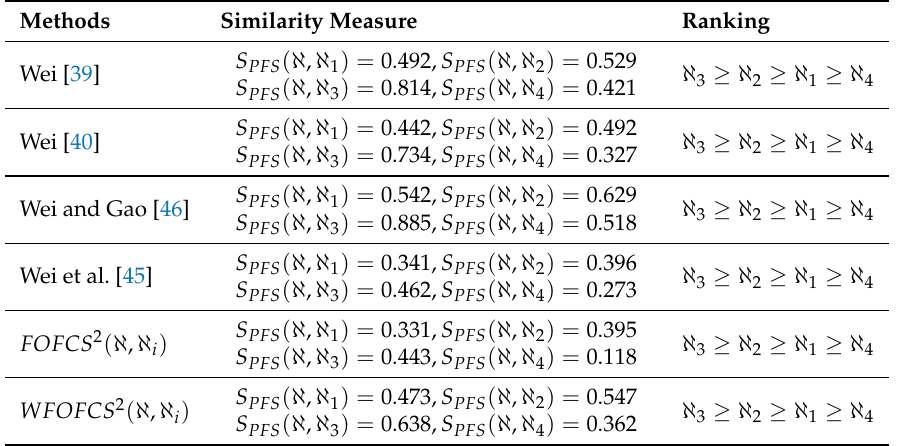
Table 5. Comparison of the defined work with the existing